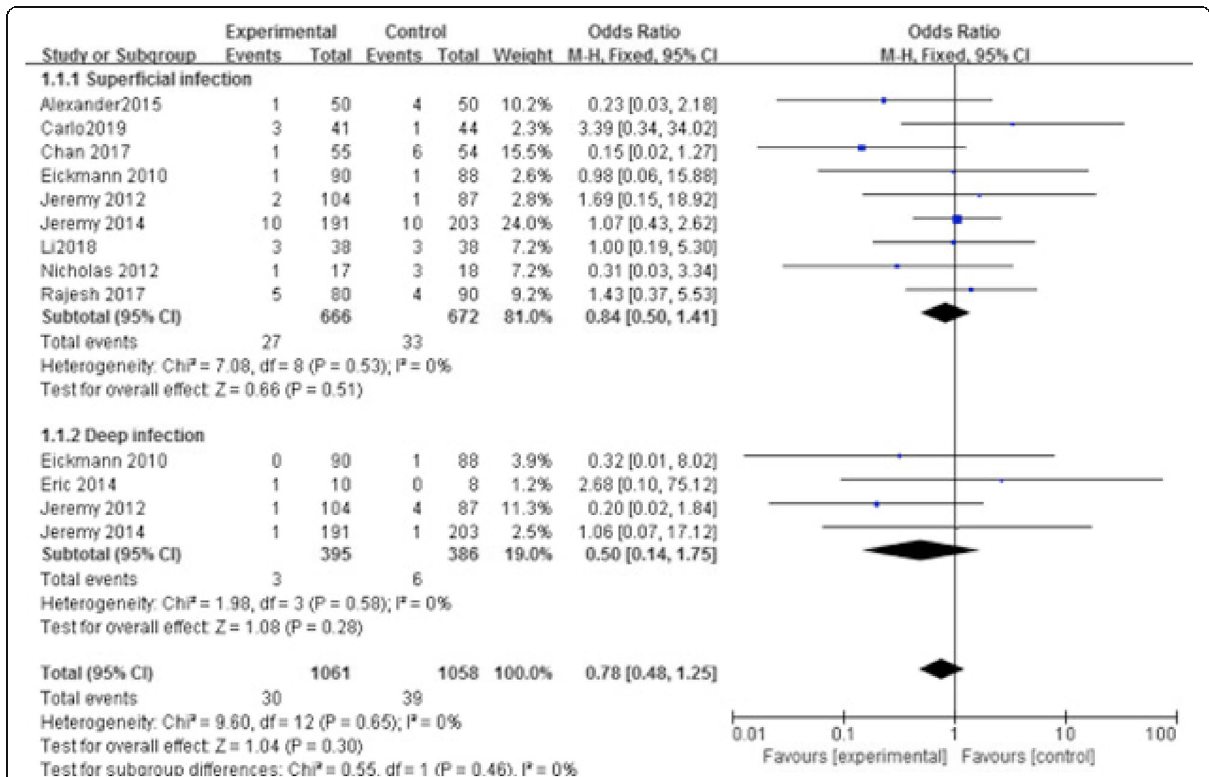
Fig. 4 Meta-analysis of superficial and deep infection rates of barbed versus conventional sutures. There was no significant difference (OR 0.84 [95% CI, 0.50, 1.41]) between barbed sutures (666 cases) and conventional sutures (672 cases) with regards to the incidence of superficial infection. There was no significant